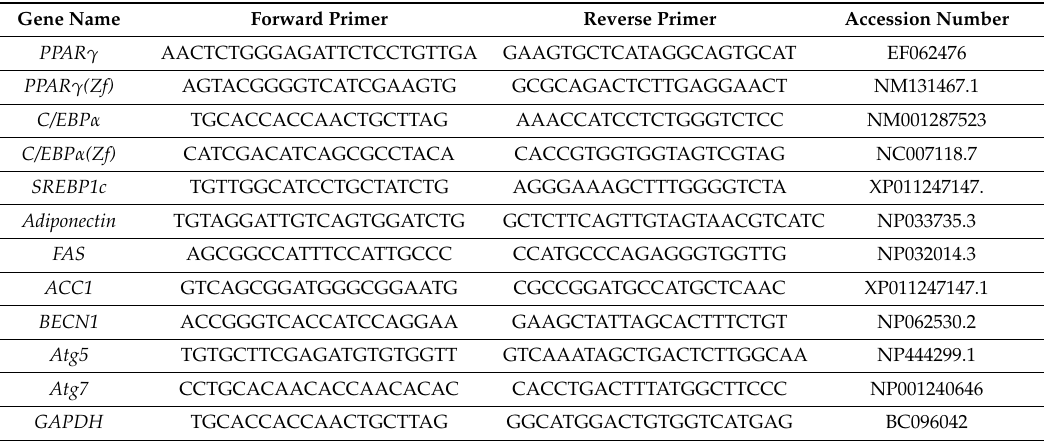
Table 1. Oligonucleotide primer sequences used for the qRT-PCR